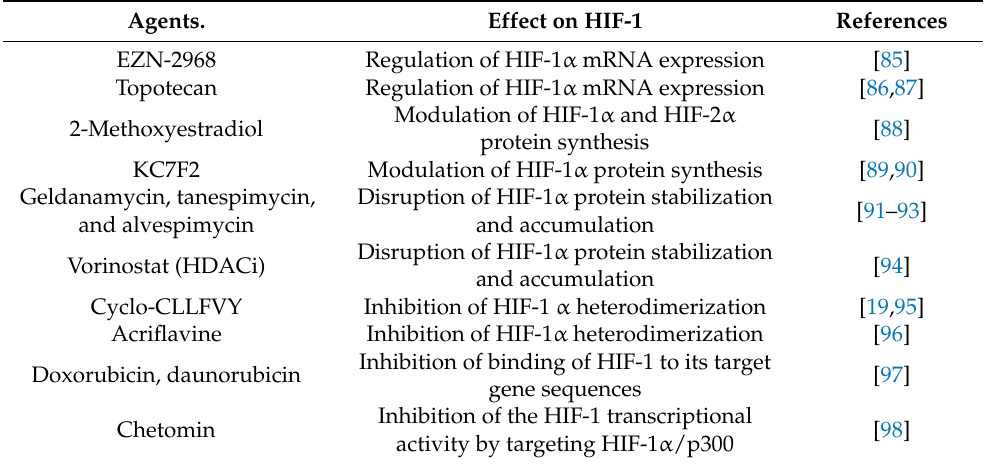
Table 1. An overview of HIF-1 inhibitors.